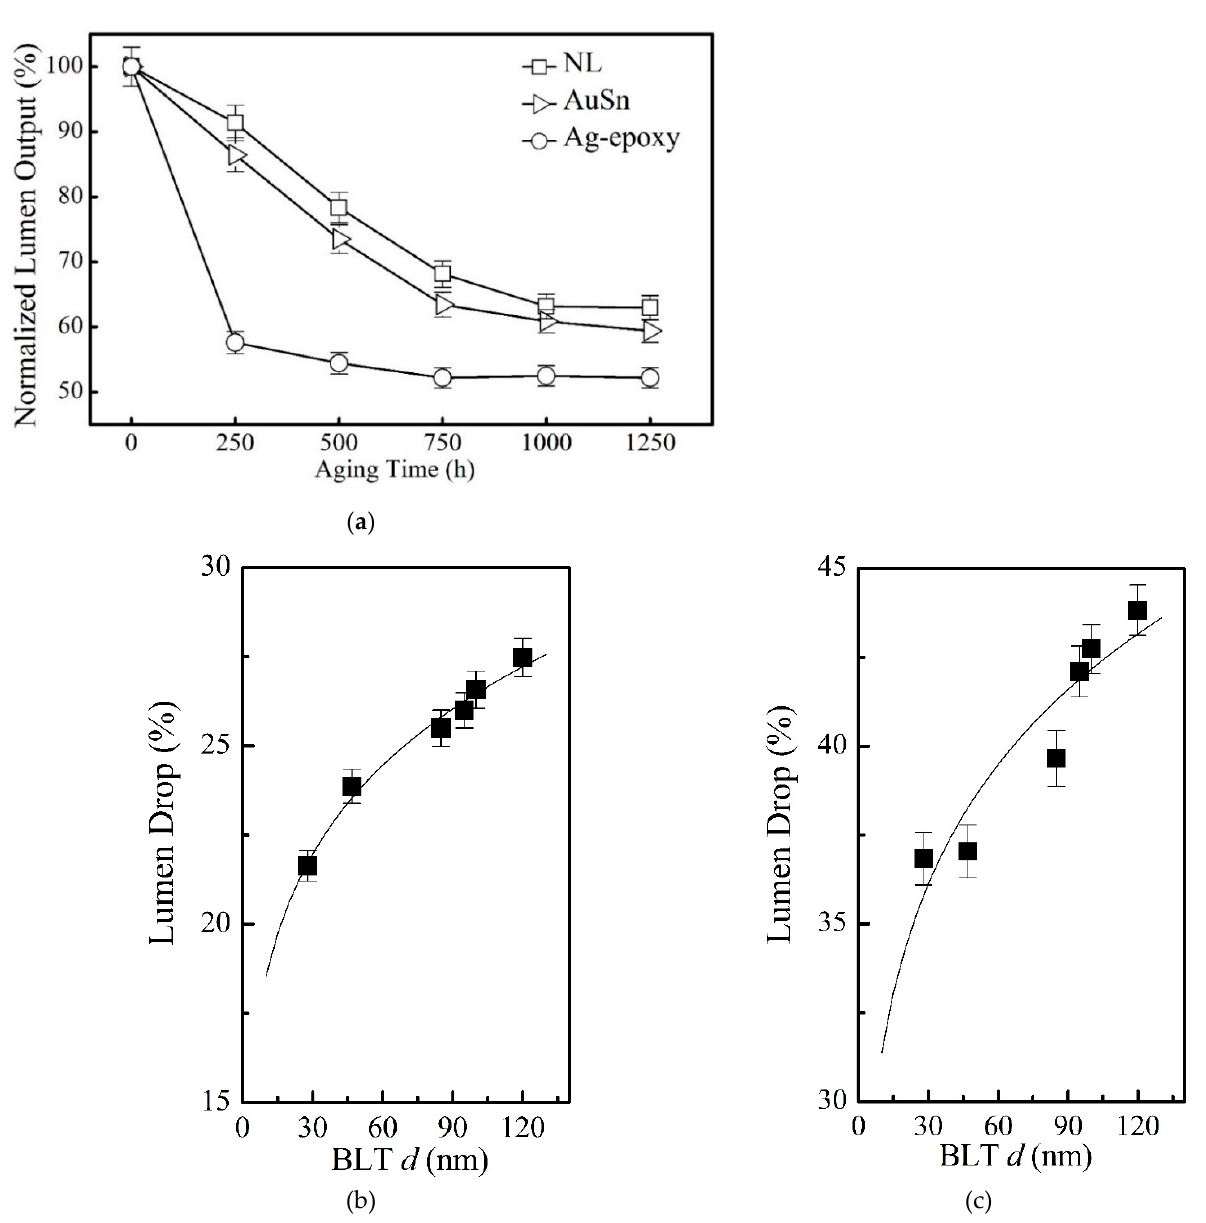
Figure 7. ( a ) Long-term lumen maintenance of the devices with three different die–substrate bonding methods as a function of aging time under the stressing condition of an operating current of 700 mA, a relative humidity RH = 85%, and a high environmental temperature of 85 °C : the solid square symbol ( □ ) represents the experimental data of NL bonding with BLT = 28 ± 5 nm, the open triangle symbol ( (cid:46) ) represents the experimental data of AuSn bonding, the open circle symbol ( ) represents the experimental data of Ag-epoxy bonding. This Wet High Temperature Operating Life (WHTOL) test (cid:35) goes beyond the requirement of the standard JEDEC No.22-A101C while extending the test duration by 25% from 1000 to 1250 hr. ( b ) The lumen drop ( I d ) at aging time of 500 hr vs BLT( d ): it follows a power law relationship I d = 0.1298 d 0.1547 as presented by the solid line; ( c ) The lumen drop ( I d ) at aging time of 1000 hr vs BLT: it follows a power law relationship I d = 0.2336 d 0.1282 as presented by the solid